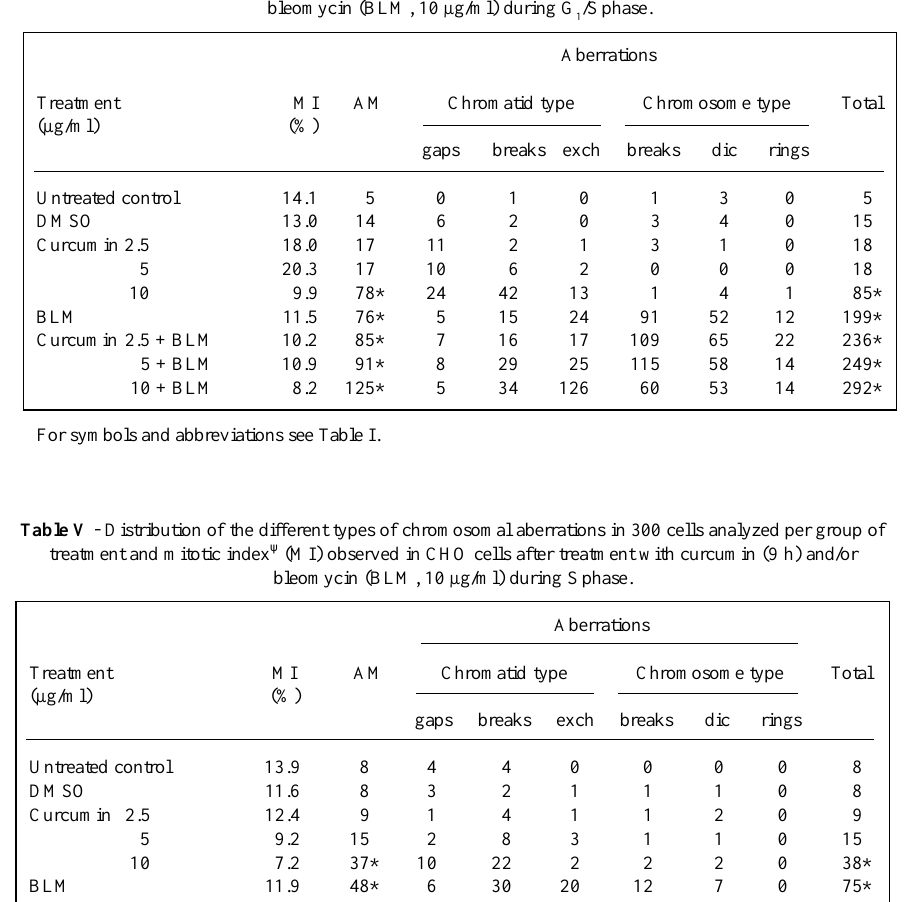
Table IV - Distribution of the different types of chromosomal aberrations in 300 cells analyzed per group of treatment and mitotic index y (MI) observed in CHO cells after treatment with curcumin (13 h) and/or /S phase. bleomycin (BLM, 10 µg/ml) during G 1